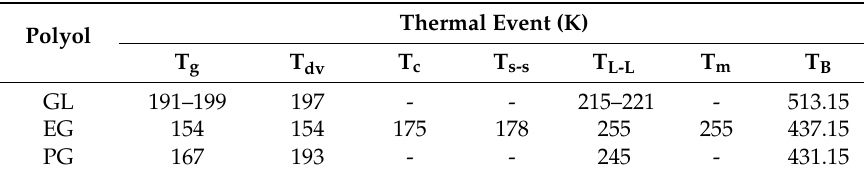
Table 2. Summary of the identification of the thermal events of polyols, and the temperature at which they